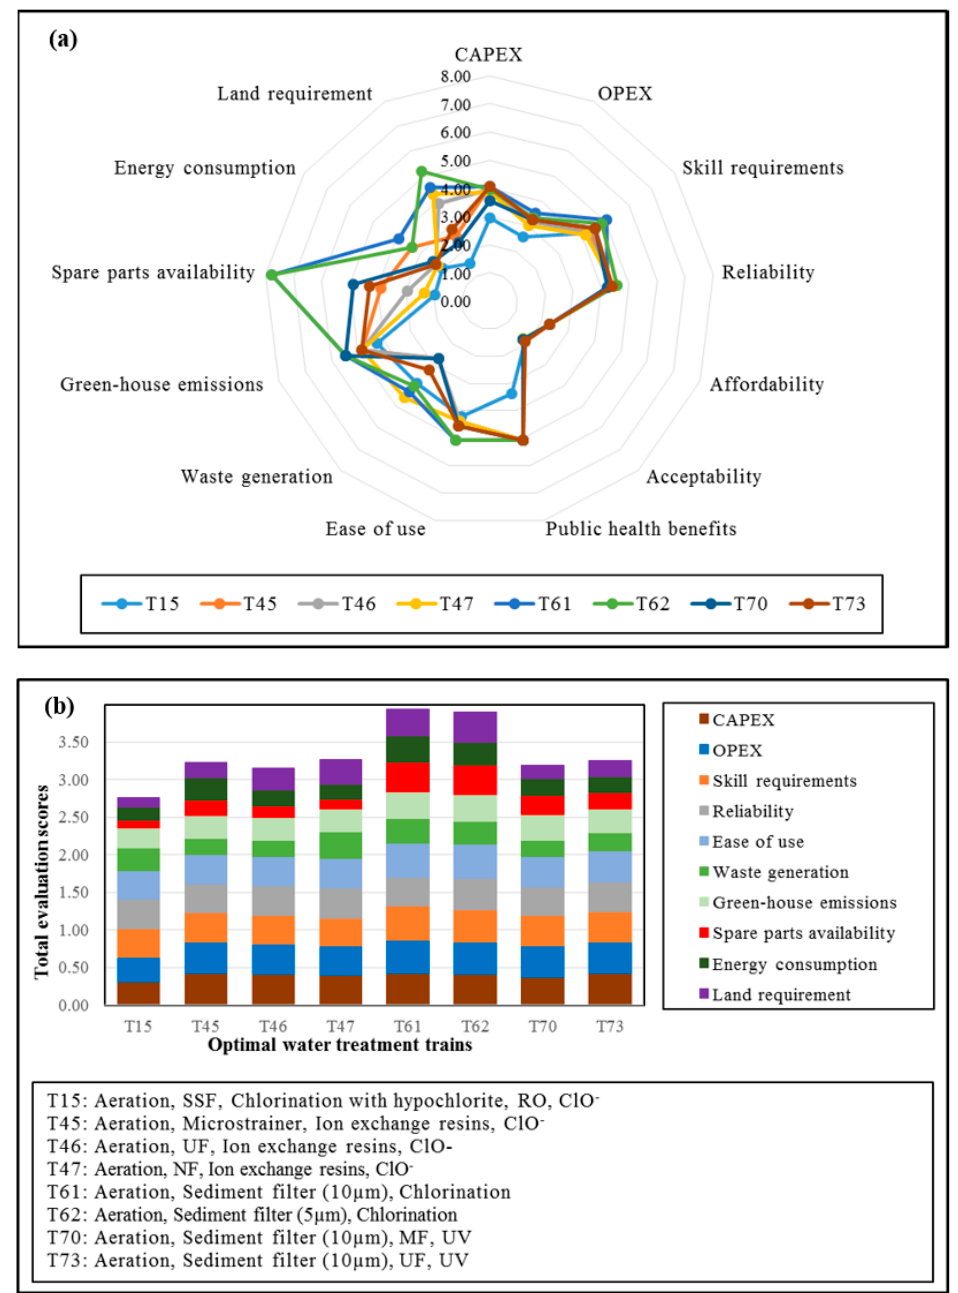
Figure 3. Results of Scenario 2—drinking water treatment systems for Bilikere: ( a ) Criteria/objective contribution star chart; ( b ) Stacked column on performance of water treatment systems.